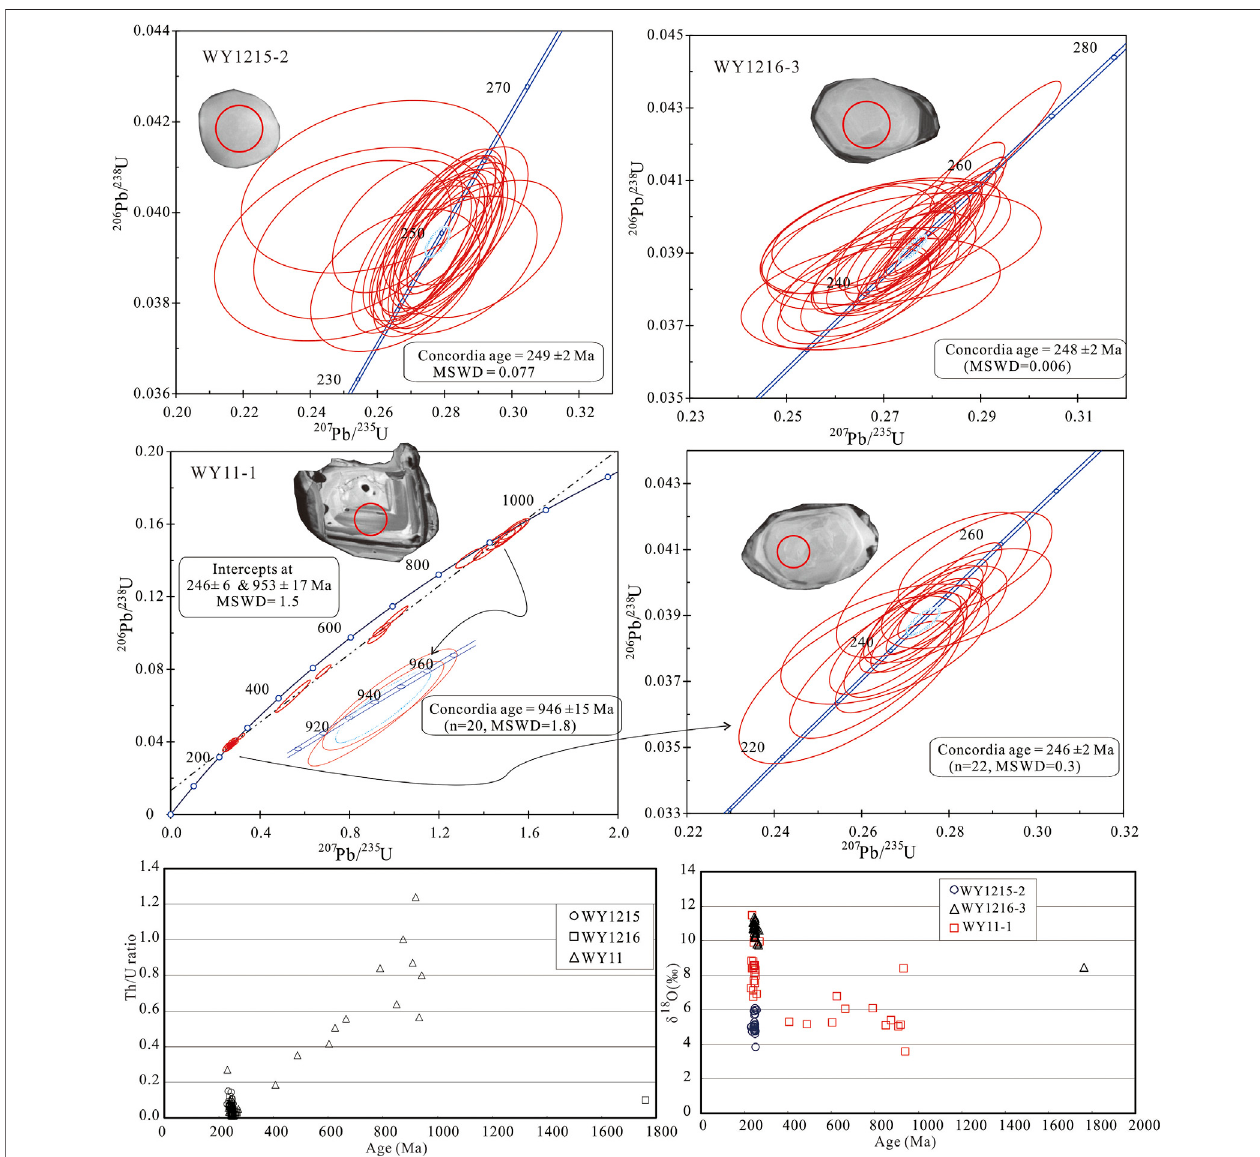
FIGURE 5 | SIMS zircon U-Pb dating results, Th/U ratio vs . U-Pb ages plots and zircon O isotopic results of the studies samples.